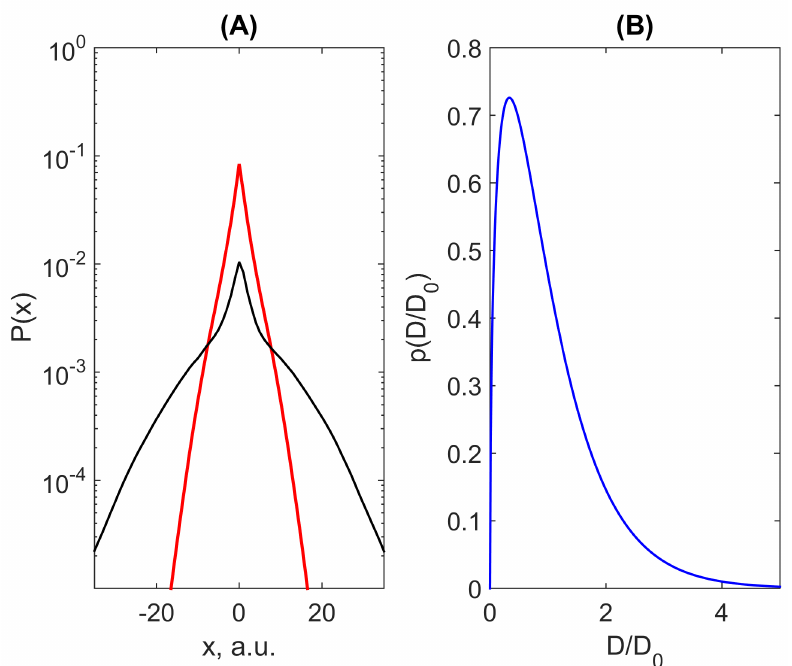
Figure 3. ( A ) Examples of evolution of probability density function for the Brownian yet non-Gaussian diffusion in 2D heterogeneous media simulated accordingly to the equilibrated Ito scheme for two time moments ( t = 10, red line, and t = 100, black line) adapted from [69] (published there under Creative Commons Attribution 4.0 licence) ( A ) and the Gamma-distribution of diffusion coefficients mimicking the heterogeneity of the medium, respectively, to the uniform value D 0 ( B ).